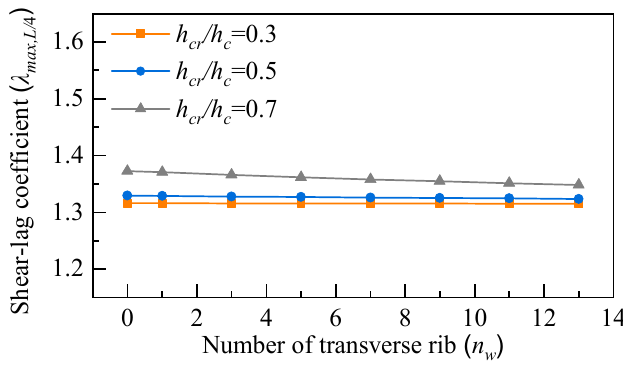
Figure 18. Relation curve of n w and λ max,L /4 .